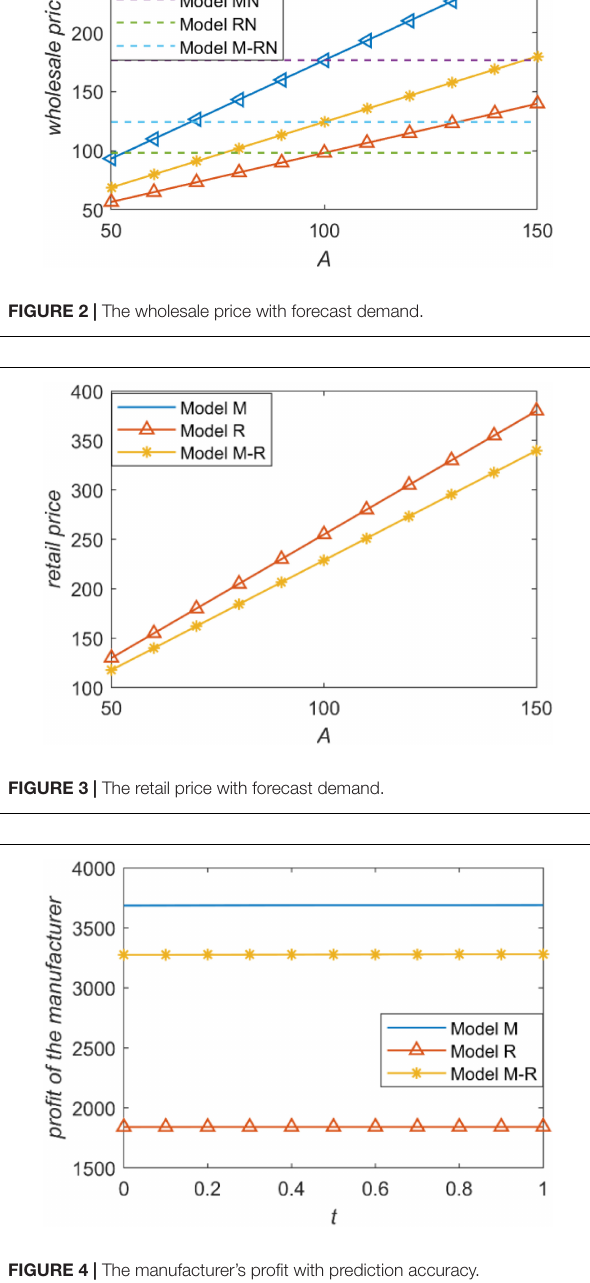
FIGURE 6 | Influence of prediction accuracy on manufacturer’s